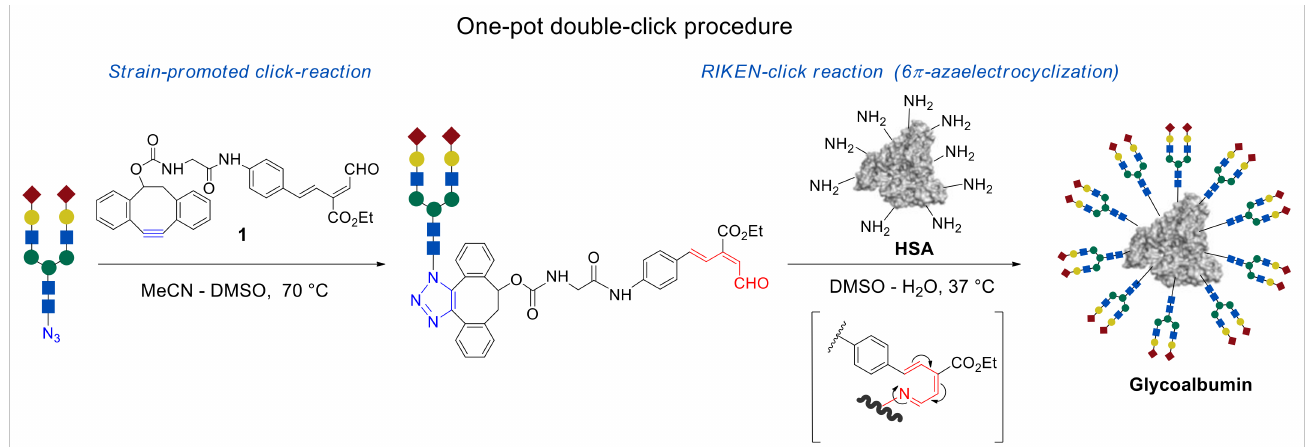
Figure 1. A strategy of two sequential click reactions based on a strain-promoted, click reaction of the dibenzocyclooctyne (azide–alkyne cycloaddition), followed by a 6 π -azaelectrocyclization of unsaturated imines in the synthesis of glycoalbumins